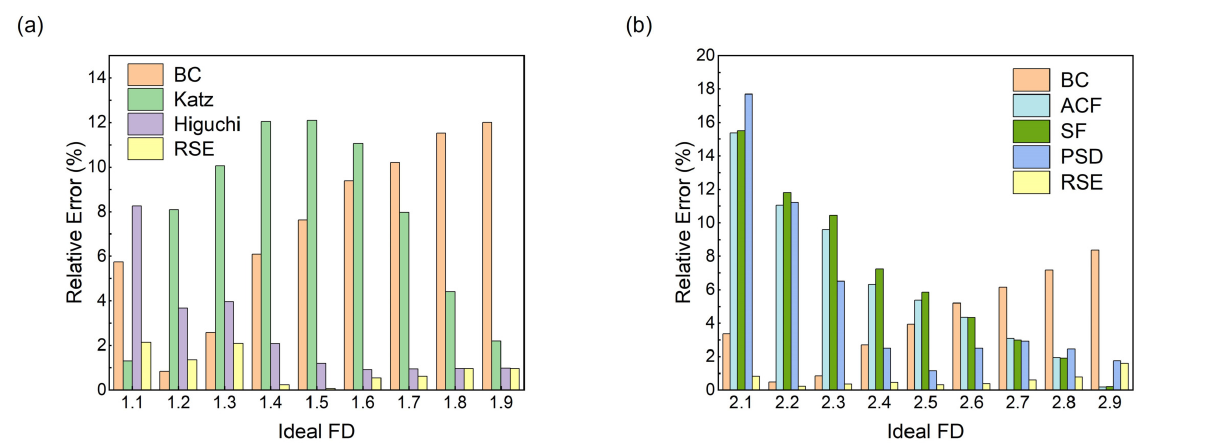
Figure 9. Errors relative to the ideal FD in W-M function of fractal calculation methods, ( a ) scanline- based fractal calculation methods including BC, Higuchi, Katz and RSE; ( b ) image-based fractal calculation methods, including ACF, SF, PSD, BC and